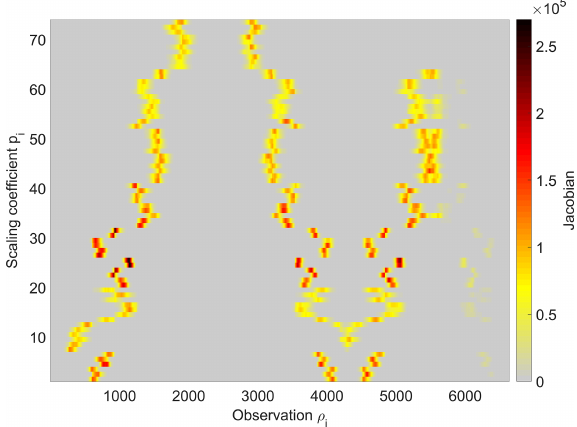
Figure 14. Jacobian with respect to x i and the observations y j for the morning flight on 6 June 2018. All scaling coefficients x i are sensitive to variations in y j and can therefore be deduced from a MAP fit. Measurements centered around observation 2300 are not covered by the model and are thus obsolete for flux estimation using this particular